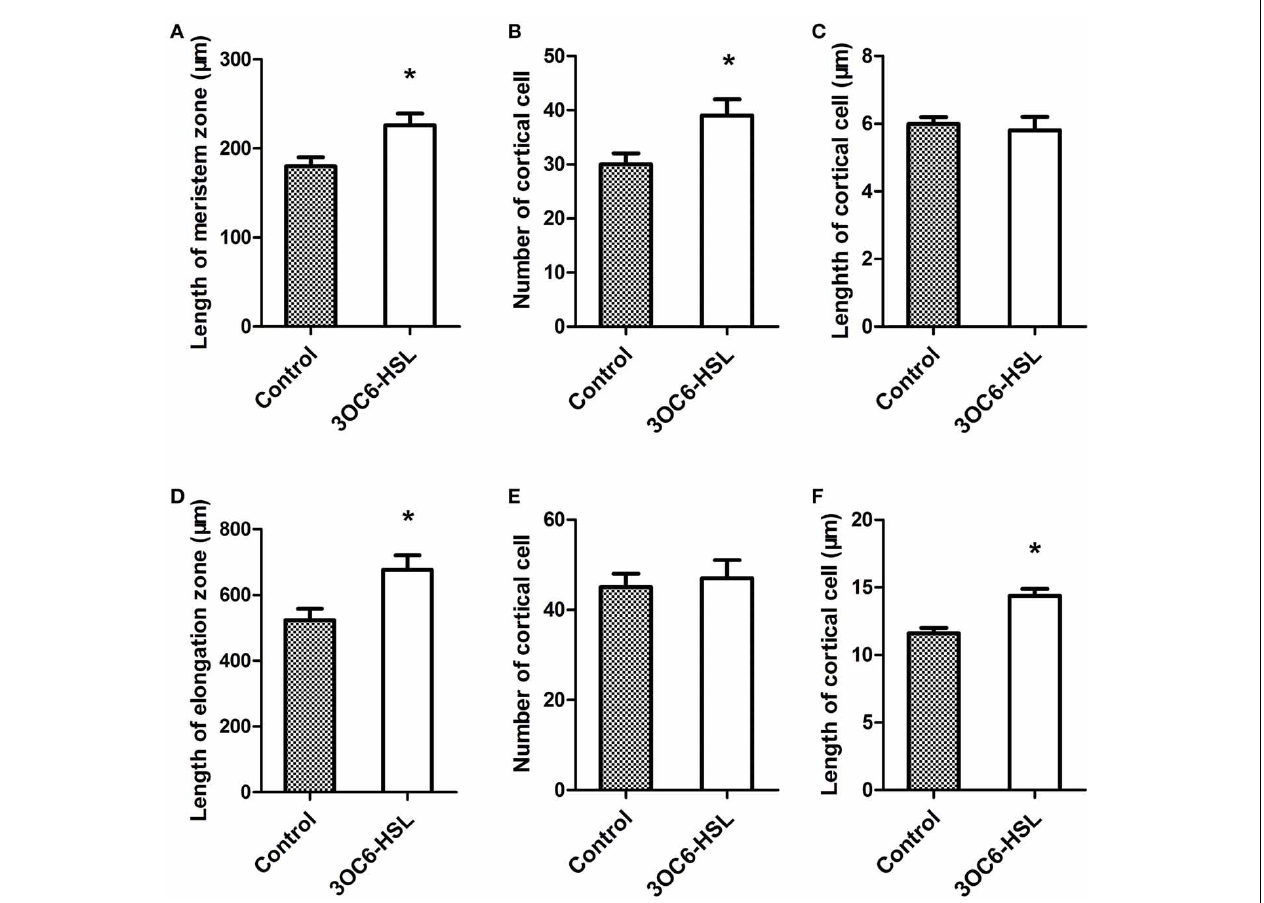
FIGURE 1 | Effects of 3OC6-HSL on Arabidopsis root meristem zone and root elongation zone. The length of the root meristem zone (A) , the number of cortical cells in the meristem zone (B) , the length of the root elongation zone (D) and the number of the cortical cells in elongation zone (E) were measured on the wild type seedlings grown on vertically oriented plates containing with or without 1 μ M 3OC6-HSL after 7 days of cultivation. The